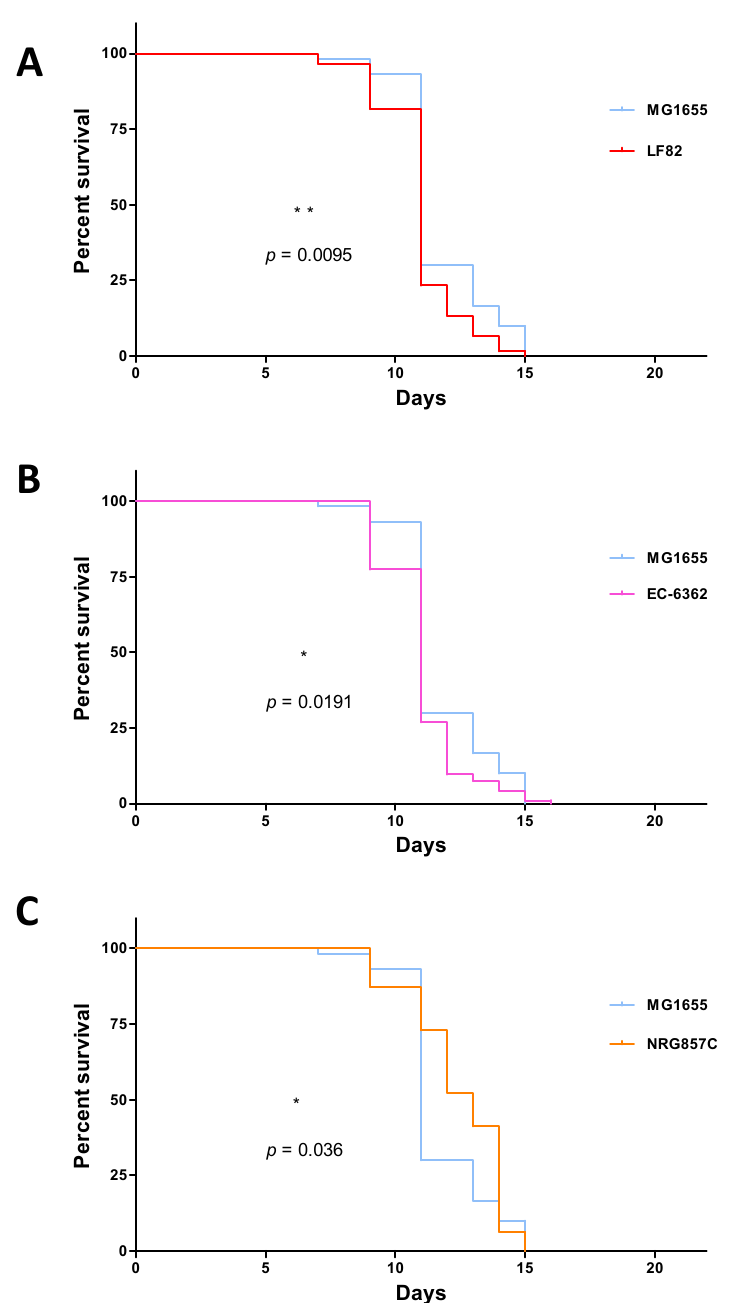
Figure 4. Pairwise comparisons of C. elegans lifespan-modulating effects of E. coli strains ( A ) MG1655 ( n = 74) vs. LF82 ( n = 78). ( B ) MG1655 ( n = 74) vs. EC-6362 ( n = 101). ( C ) MG1655 ( n = 74) vs. NRG857c ( n = 65). The “ n ” values in brackets correspond to the initial number of larvae investigated for each bacterial strain. The statistical significance of intergroup differences was assessed with a log-rank (Mantel-Cox) test; *: p < 0.05; **: p < 0.01).